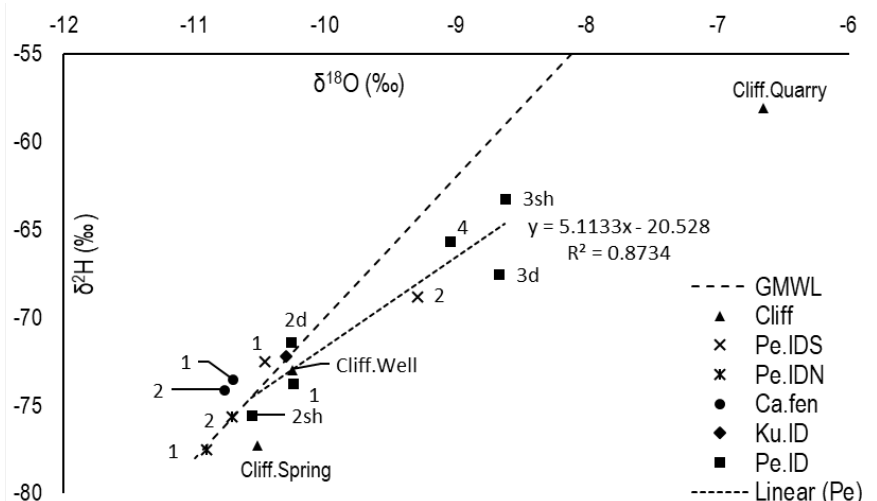
Figure 5. The stable isotope content of δ 18 O versus δ 2 H (‰) in 16 groundwater samples in relation to the global meteoric water line (GMWL). A trendline was calculated for the samples from the Peterezera inter- dune mire (Pe.ID1 to